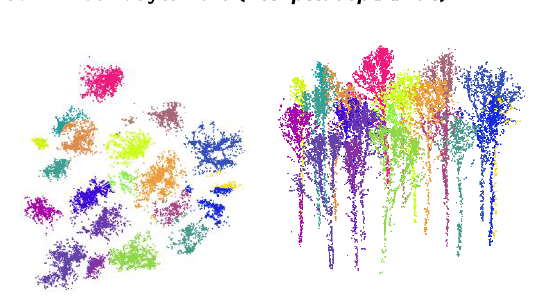
Figure 2. Top and the front of Plot B segmented using Method 5 (calibrated), with each separate tree assigned a random colour. Sycamores (Figure 2) in plot B have relatively narrow crowns with very little overlap between the adjacent trees, which explains relatively low level of undersegmentation in comparison with the other plots in Test 1. Instances of oversegmentation are more likely due to the branching structure, where two major branches of one tree are identified as two different specimens. It is the plot with highest level of detection accuracy in Test 2, but lower recall than in the case of Test 1, as the CHM resolution is too low and size of the kernel too large for the plot. Method 5 obtained the highest accuracy scores in both tests (F-score > 0.9). 3.3 Plot C: English oak ( Quercus robur ) Plot C is characterized by broad, spread out crowns (Figure 3). This feature might explain the larger amount of overdetected trees in Test 2 in comparison with the other plots (up to 15 in case of Method 3). It is more difficult to establish local maxima in trees with broad crowns as they do not have one characteristic